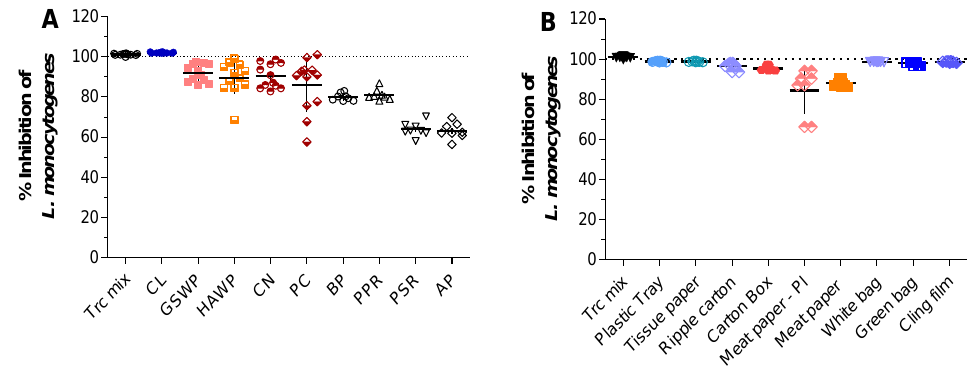
Figure 2. Antimicrobial activity against L. monocytogenes of Trc mix-treated ( A ) laboratory materials and ( B ) commercial materials used in the food industry. Each data set represents the mean of eight and six technical repeats for the laboratory and commercial materials, respectively. The error bar represents the SD of the data cluster. Abbreviations: cellulose (CL), mixed cellulose filters GSWP (0.22 µm) and HAWP (0.45 µm), cellulose nitrate (CN — 0.45 µm), polycarbonate (PC — 0.4 µm), black polystyrene plate (BP), polypropylene round bottom plate (PPR), polystyrene round bottom plate (PSR), and polystyrene plate (AP). Statistical analysis summary can be found in the Supplementary Materials Tables S2 and S3.